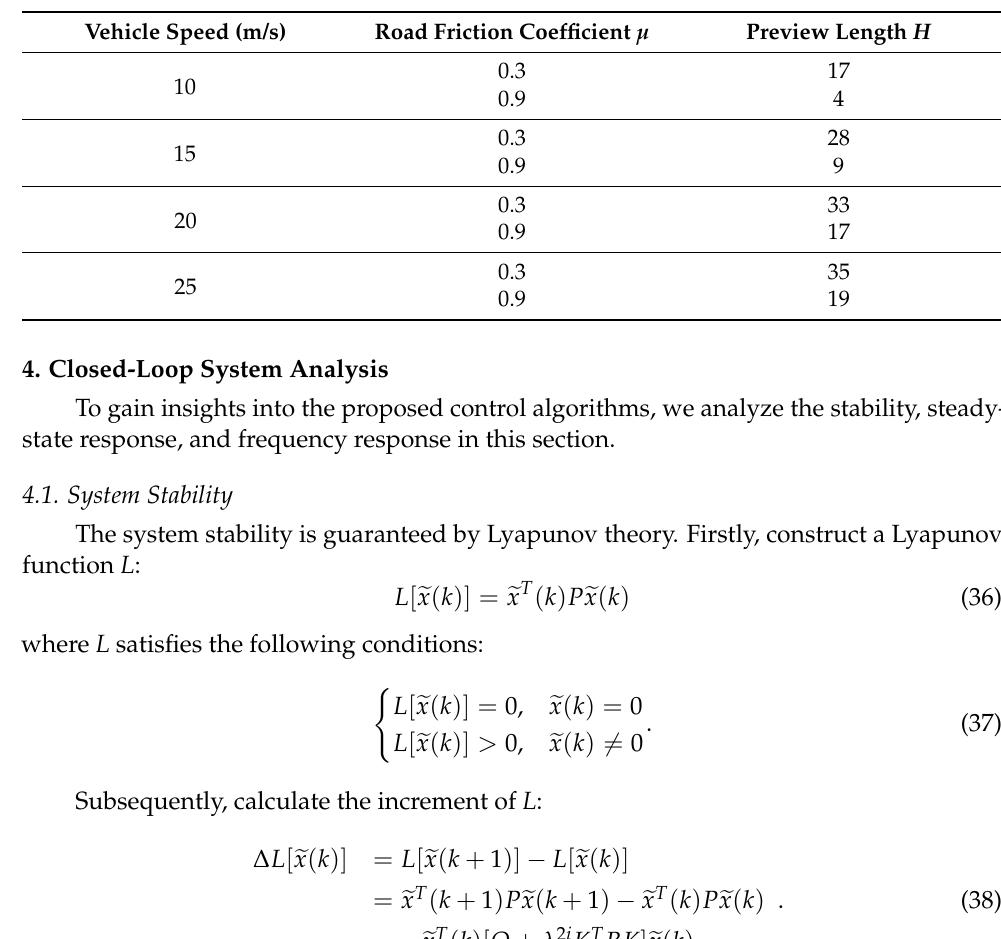
Table 2. Optimized preview